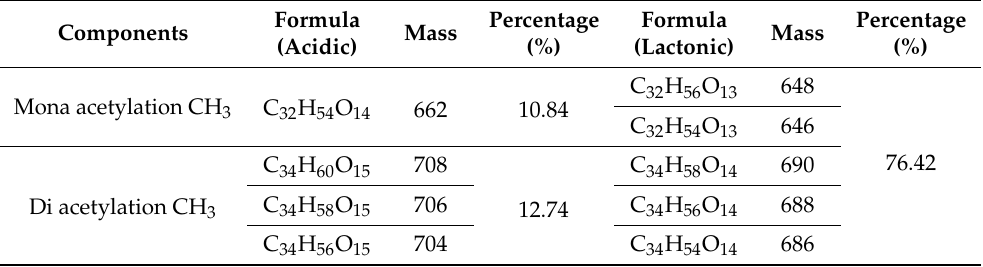
Table 1. Different Structural Modifications of SL.